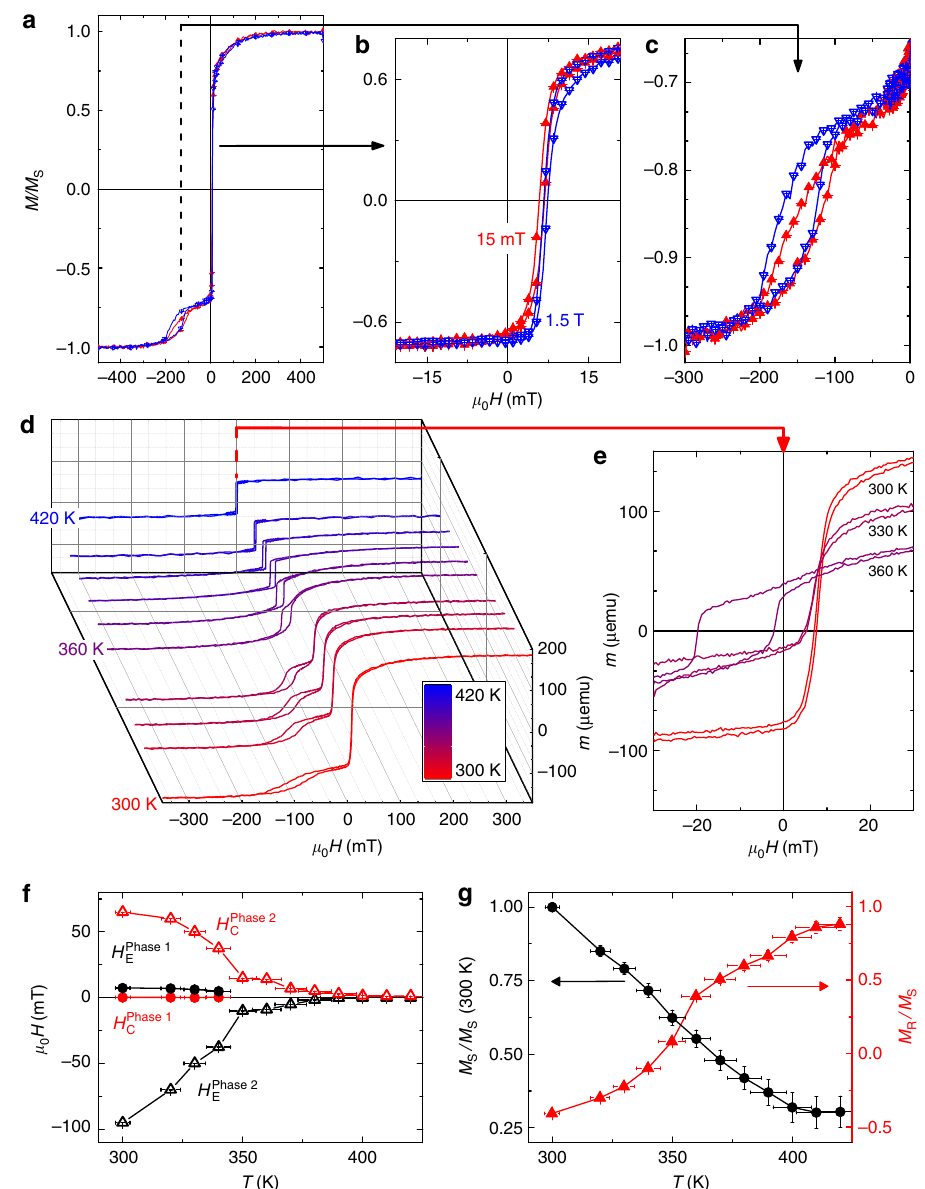
Figure 2 | Magnetometry results for sample C (Gd 0.53 Fe 0.47 /NiCoO). ( a ) Room-temperature hysteresis loops under different cooling fields of 15mT (red) and 1.5T (blue). ( b , c ) Zoomed-in views of phase 1 and phase 2, respectively, as indicated by arrows. Temperature-dependent ( d ) hysteresis loop (300–420K, marked by the scale bar, with a zoomed-in view shown in e ), ( f ) coercivity and exchange bias, and ( g ) saturation magnetization and squareness are shown after field cooling in 15mT. Error bars are determined by the machine sensitivity limits. For clarity, not all data points are